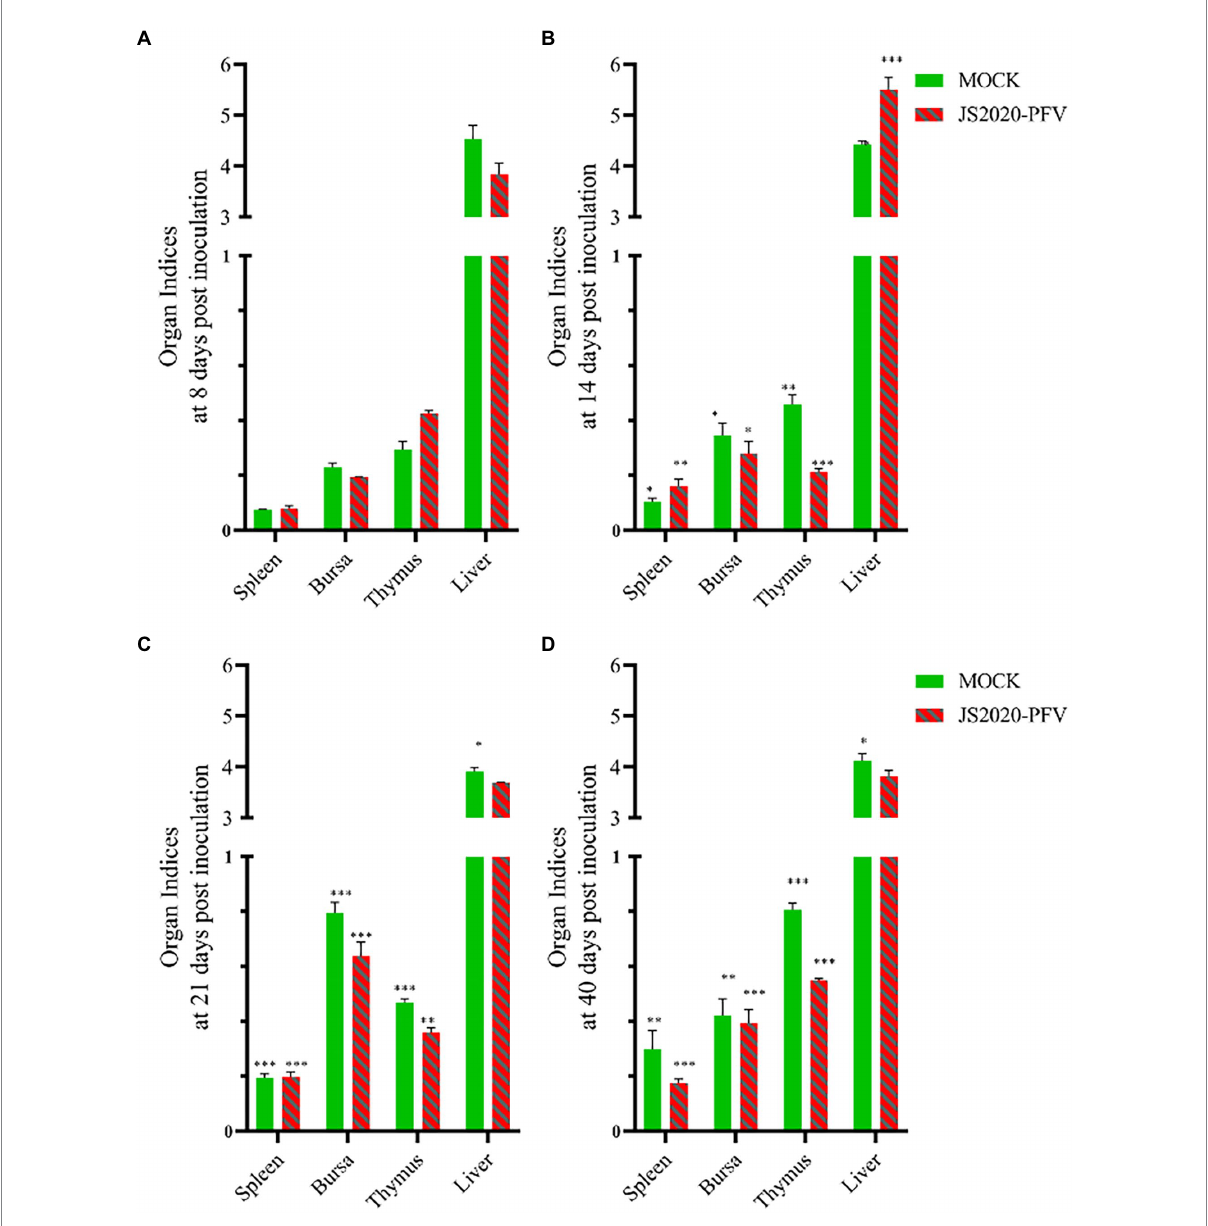
FIGURE 5 Organ indices at different days post inoculation (d.p.i.; n = 4/group). Organ index = immune organ weights (g) / body weight (g) × 100% × 100, (A) Organ indices at 8 d.p.i. (B) Organ indices at 14 d.p.i. (C) Organ indices at 21 d.p.i. (D) Organ indices at 40 d.p.i. * p < 0.05, ** p < 0.01, *** p <